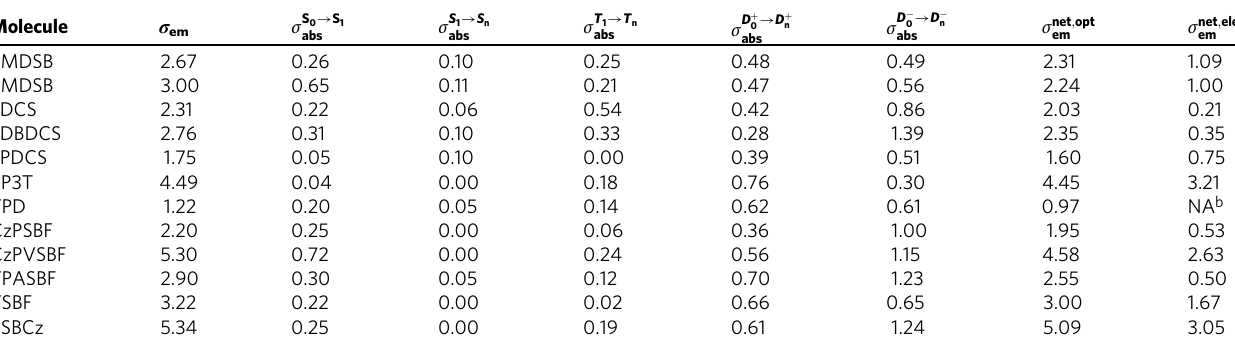
Table 3 Values of S 1 emission cross section and various absorption cross sections at λ em of 12 candidates a .